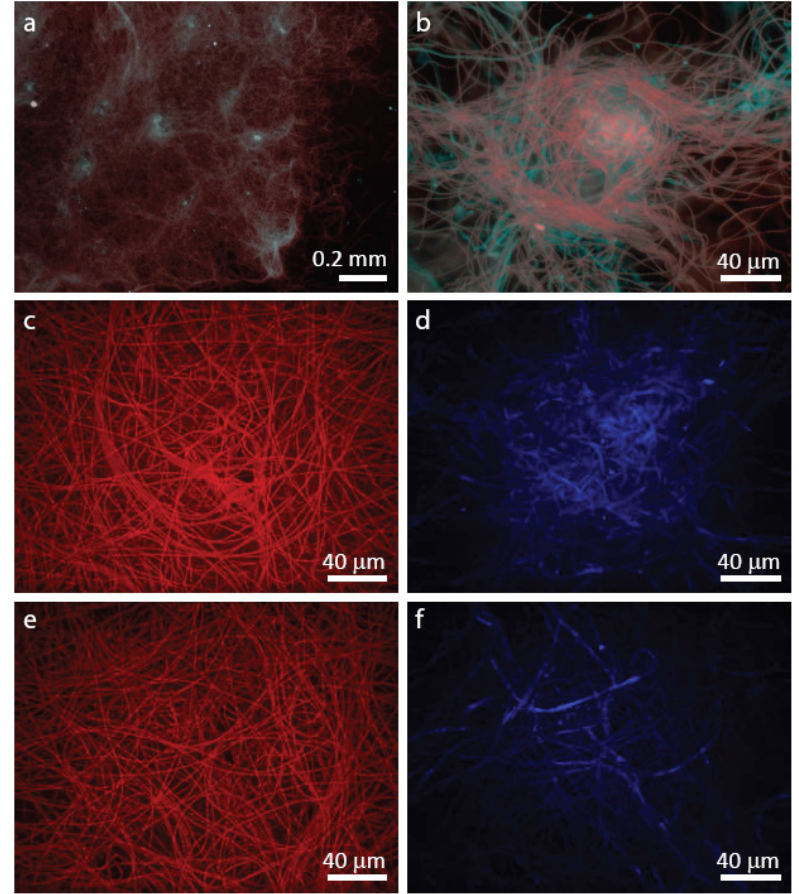
Figure 4. Epifluorescence photomicrographs of clumps and cyanobacterial sheaths. Red and blue, respectively, show Chl a autofluorescence and extracellular polymeric material (EPS) stained by Calcofluor White, respectively. ( a ) Clumped mat; ( b ) Clump; ( c ) Epifluorescence confocal micrograph of cyanobacterial filaments in a clump; ( d ) EPS in the same field of view as in ( c ); ( e ) Epifluorescence confocal micrographs of cyanobacteria in a flat mat; ( f ) EPS in the same field of view as in ( e ). Note that sheaths stainable by Calcofluor White rarely occur within bundles of well-aligned filaments, e.g., lower right in ( e